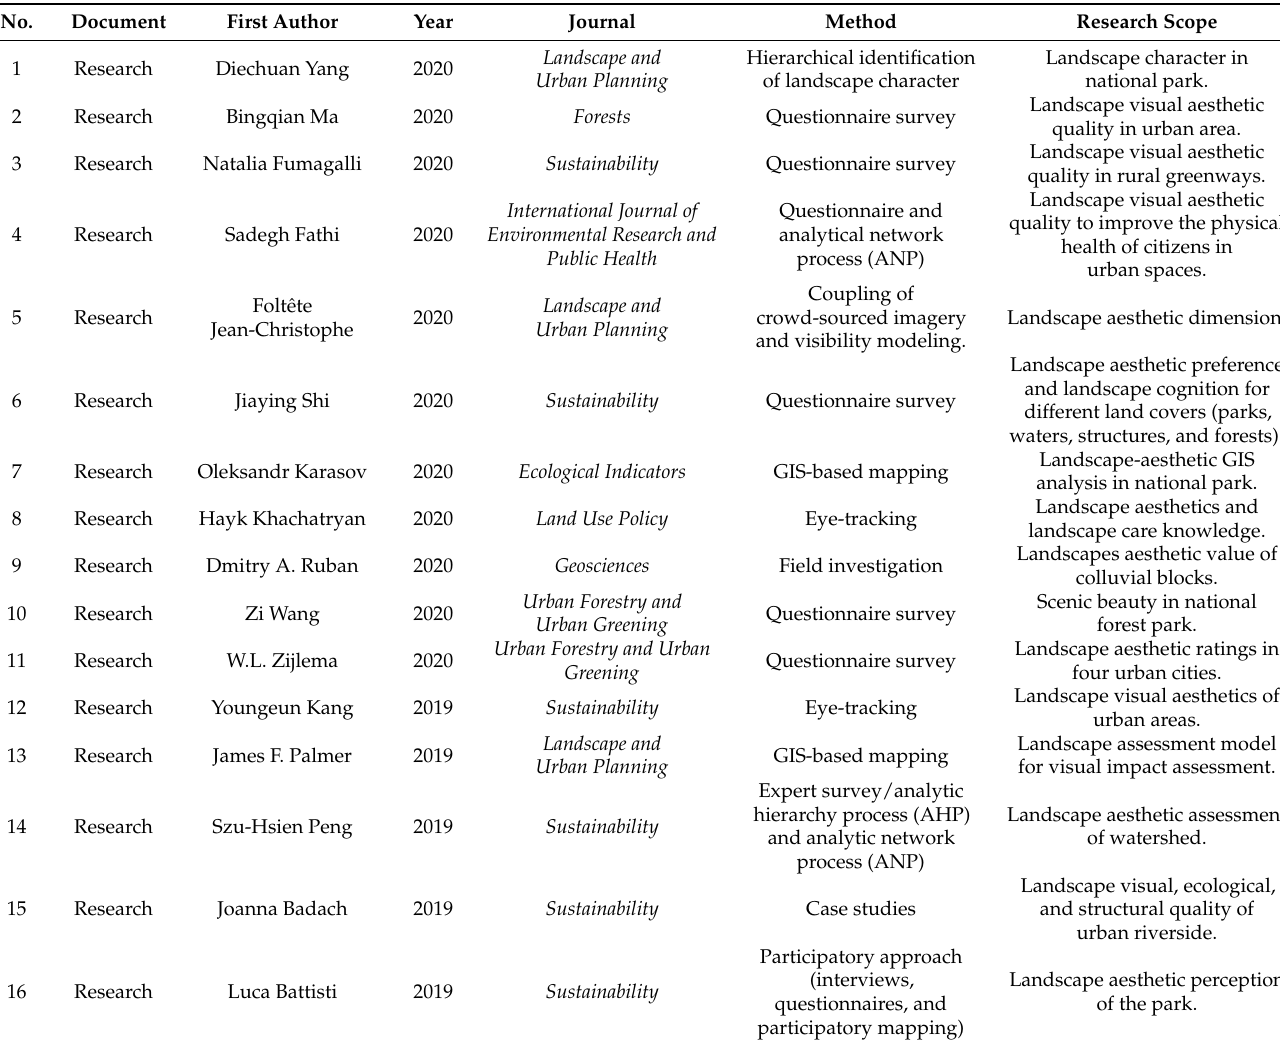
Table A1. Summary table of all 81